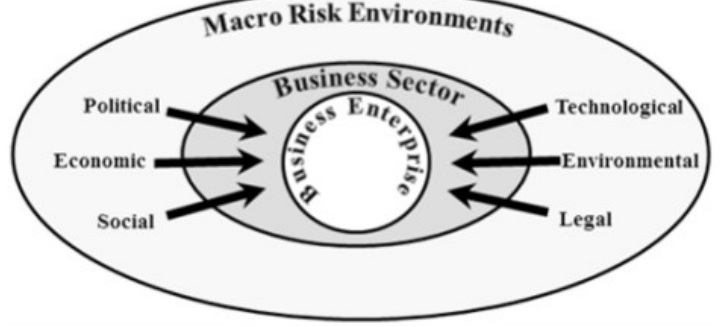
Figure 1. The Macro Risk Forces in Business